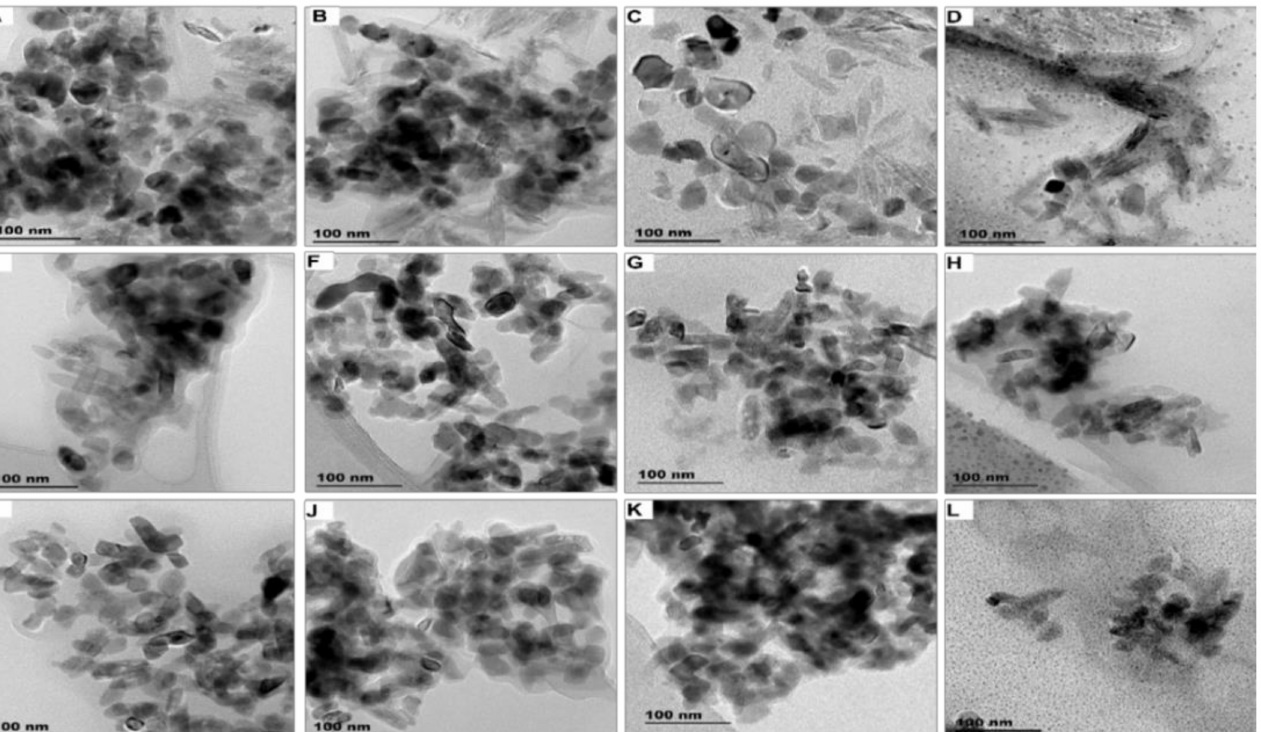
Figure 1. TEM images of product-released ENMs obtained under light conditions for SUN1 detected in Milli-Q water ( A ), freshwater ( B ), swimming pool water ( C ), seawater ( D ), SUN2 detected in Milli-Q water ( E ), freshwater ( F ), swimming pool water ( G ), seawater ( H ) and SUN3 detected in Milli-Q water ( I ), freshwater ( J ), swimming pool water ( K ), seawater ( L